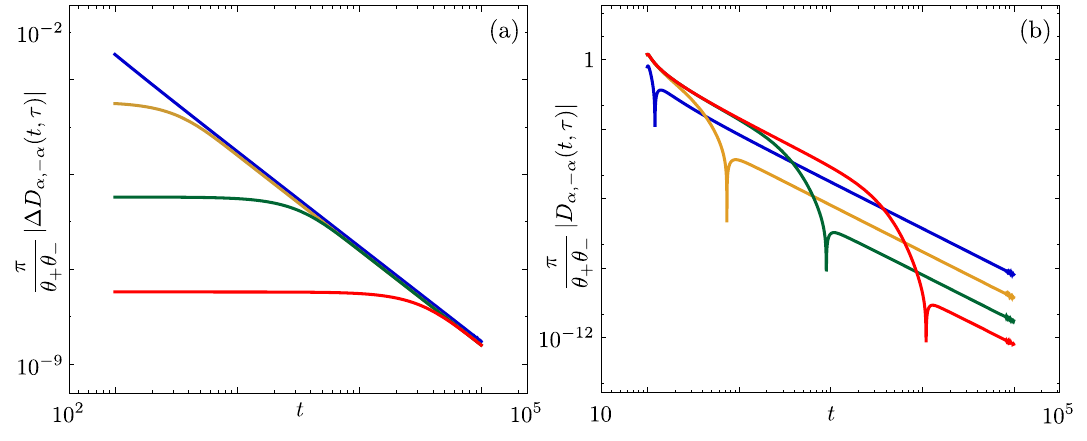
π | ∆ D ( t , τ ) | as a function of time t for different temperatures: Figure 1: (a) Plot of α , − α θ + θ − T = 10 − 4 (red), T = 10 − 3 (green), T = 10 − 2 (yellow), T = 10 − 1 (blue). (b) Plot of the full π | D ( t , τ ) | as a function of time t for different temperatures: T = 10 − 4 cross-correlator α , − α θ + θ − (red), T = 10 − 3 (green), T = 10 − 2 (yellow), T = 10 − 1 (blue). Here, τ = 10, K = 0.6, time units ω − 1 K and temperature units ω f i f